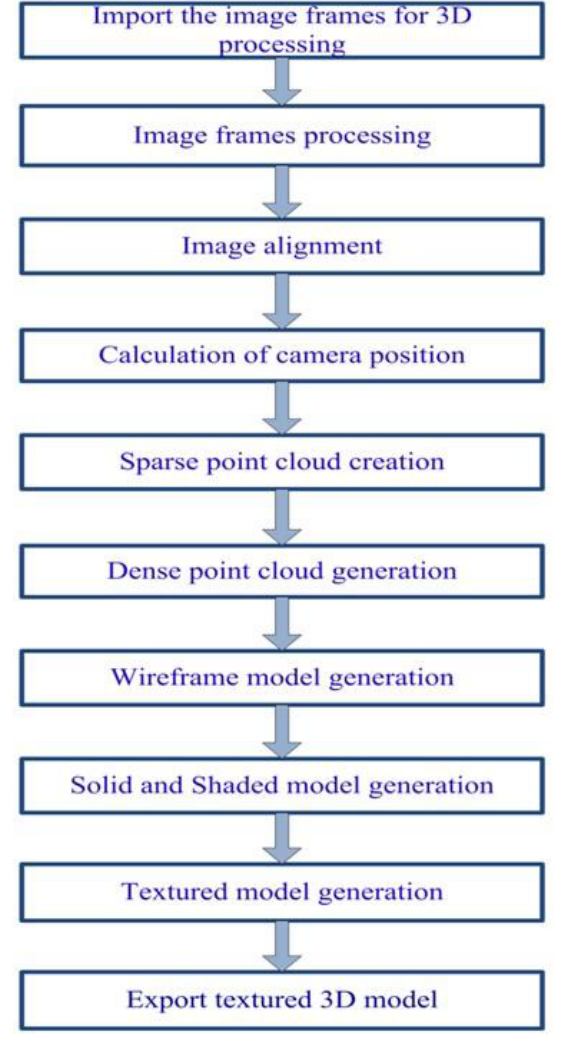
Figure 4: Flow diagram of methodology for 3D data processing